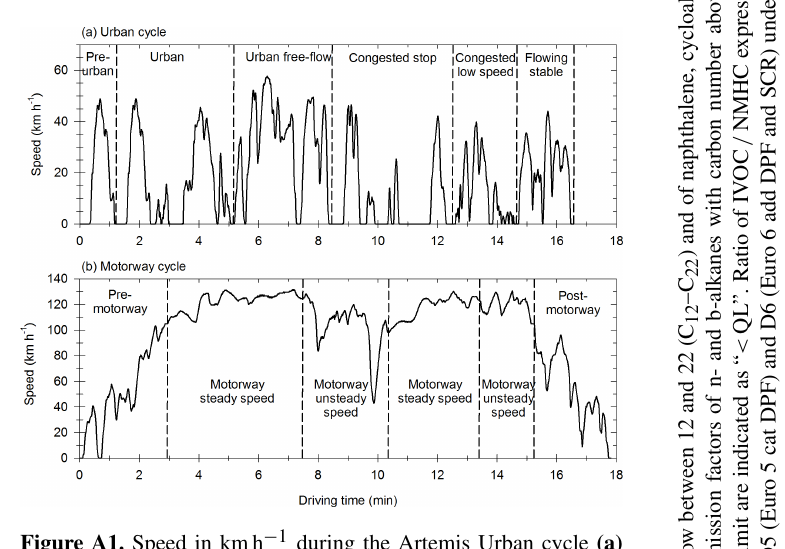
Figure A1. Speed in kmh − 1 during the Artemis Urban cycle (a) and the Artemis Motorway cycle (b) , with the different types of driving found under those